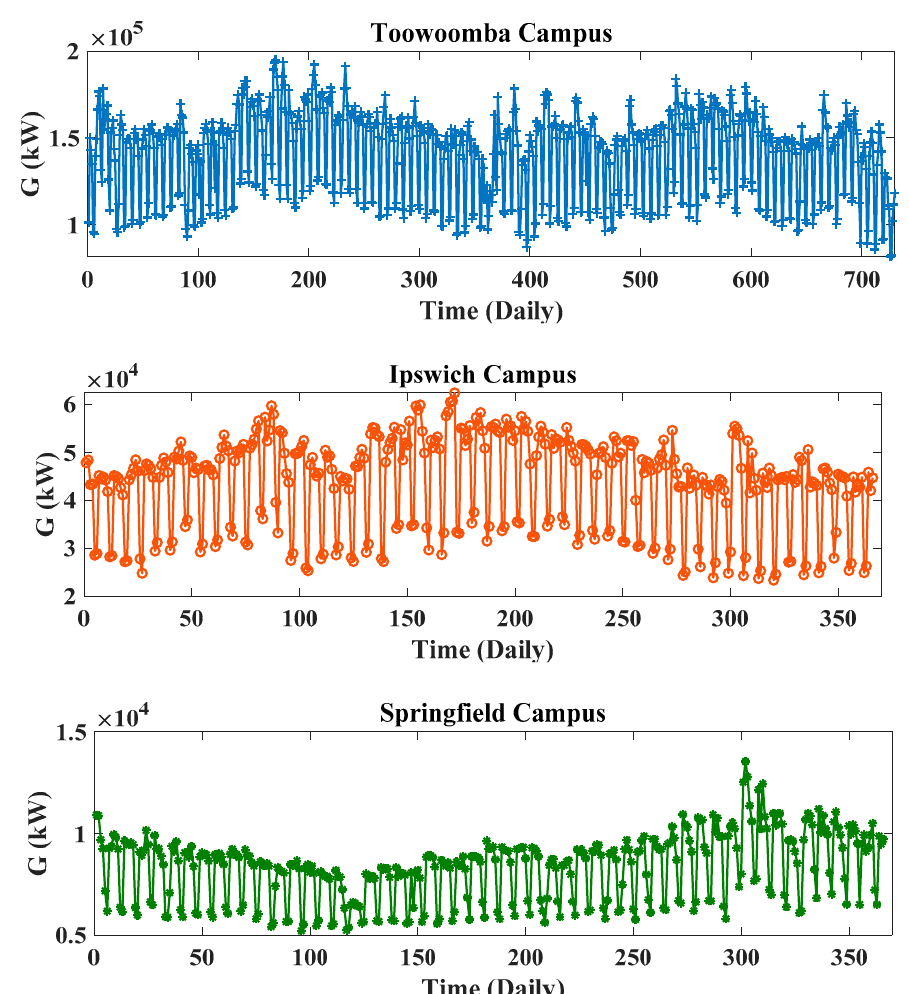
Figure 2. Daily electricity demand ( G , kW) time-series for the three study sites of Toowoomba, Ipswich, and Springfield campuses.